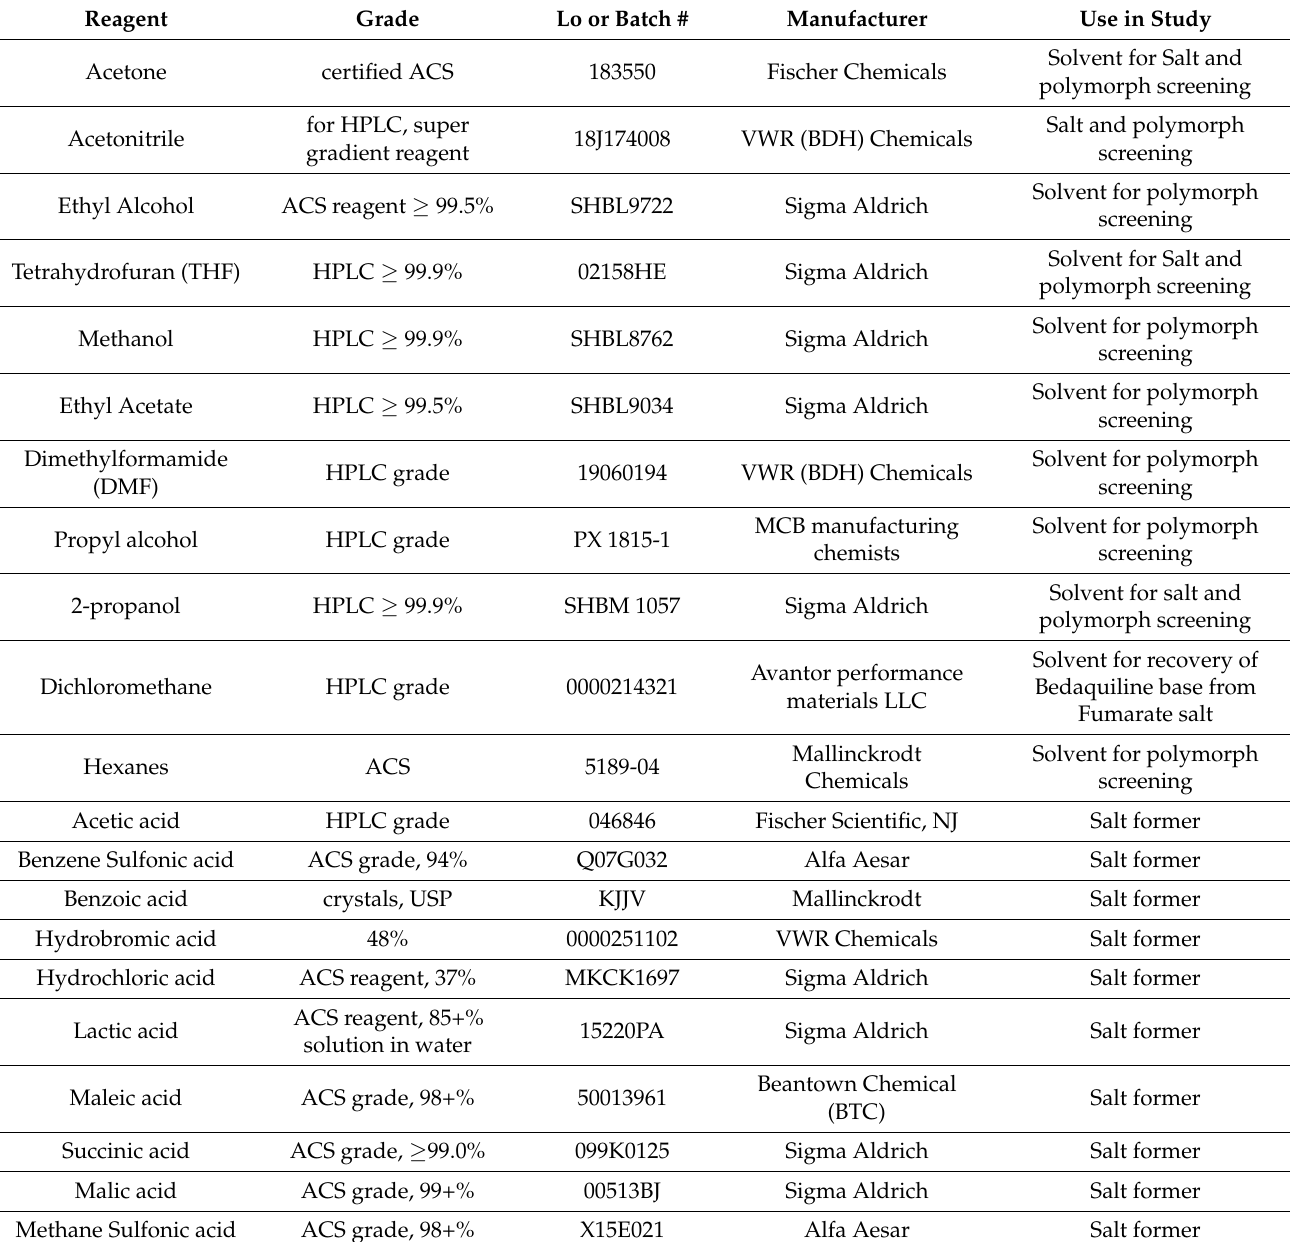
Table A1. Reagents’ properties and stages of the experiments at which they were employed.